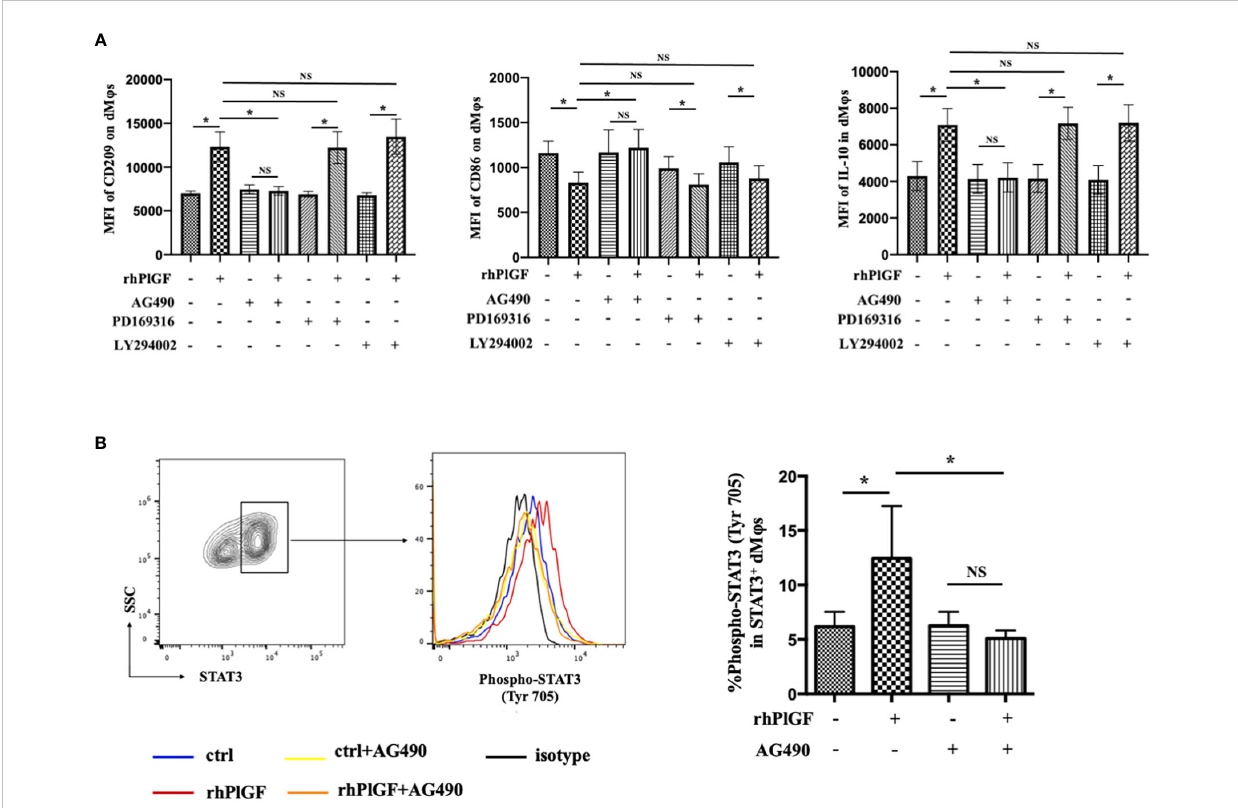
FIGURE 3 PlGF drived the M2-like polarization by promoting STAT3 phosphorylation at Tyr 705 in macrophages from early decidua. (A) The MFI levels of CD209, CD86, and IL-10 in decidual macrophages (dM j s) by fl ow cytometry (FCM) analysis after 48 hour treatment with recombinant human PlGF (rhPlGF, 100 ng/mL) following 1 hour pretreatment with AG490 (10 m M), LY294002 (10 m M) or PD169316 (10 m M) (5 independent experiments). (B) The phosphorylation level of STAT3 at tyrosine 705 (Tyr 705) in dM j s by FCM analysis after 48 hour treatment with rhPlGF (100 ng/mL) following 1 hour pretreatment with AG490 (10 m M) (4 independent experiments). Data were analyzed by paired t-test or Wilcoxon matched-pair signed-ranks test, and shown as mean ± SEM. * P < 0.05, and NS no statistically difference. MFI, mean fl uorescence